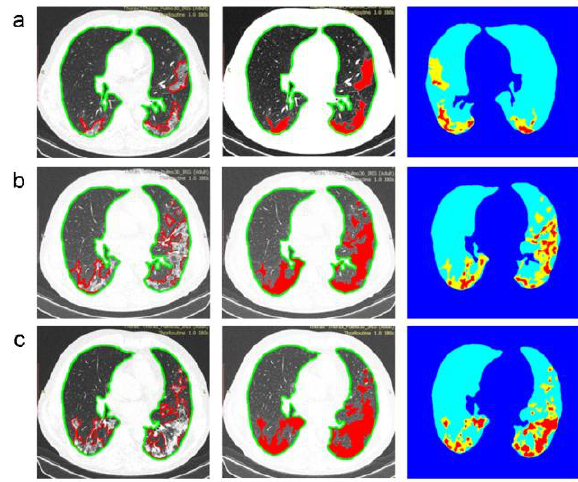
Figure 12 . Examples of CT image processing of lungs with COVID-19 (2nd patient): a) observation on the 3rd day of illness; b) observation on the 7th day of illness; c) observation on the 14th day of illness.